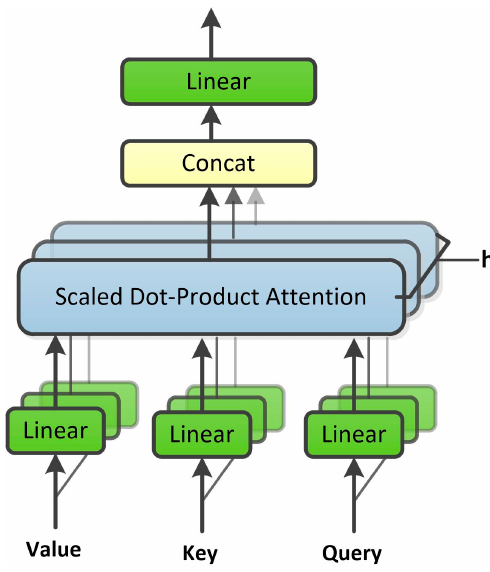
Figure 3. Architecture of the multi-head a tt ention mechanism.